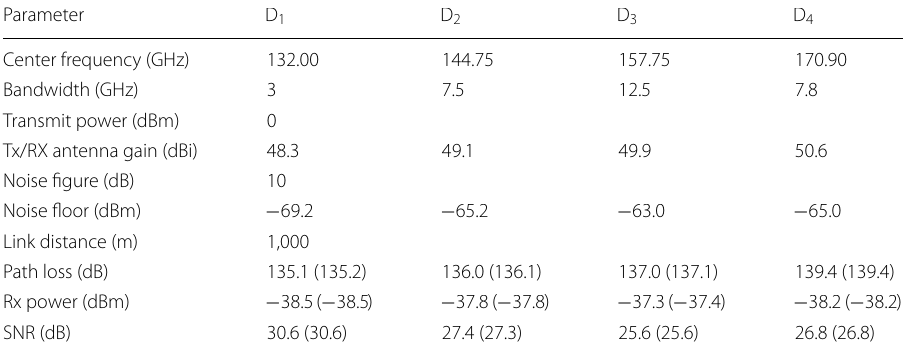
Table 1 Link budget calculations for the D band channels. Values in brackets are the exact theoretical values